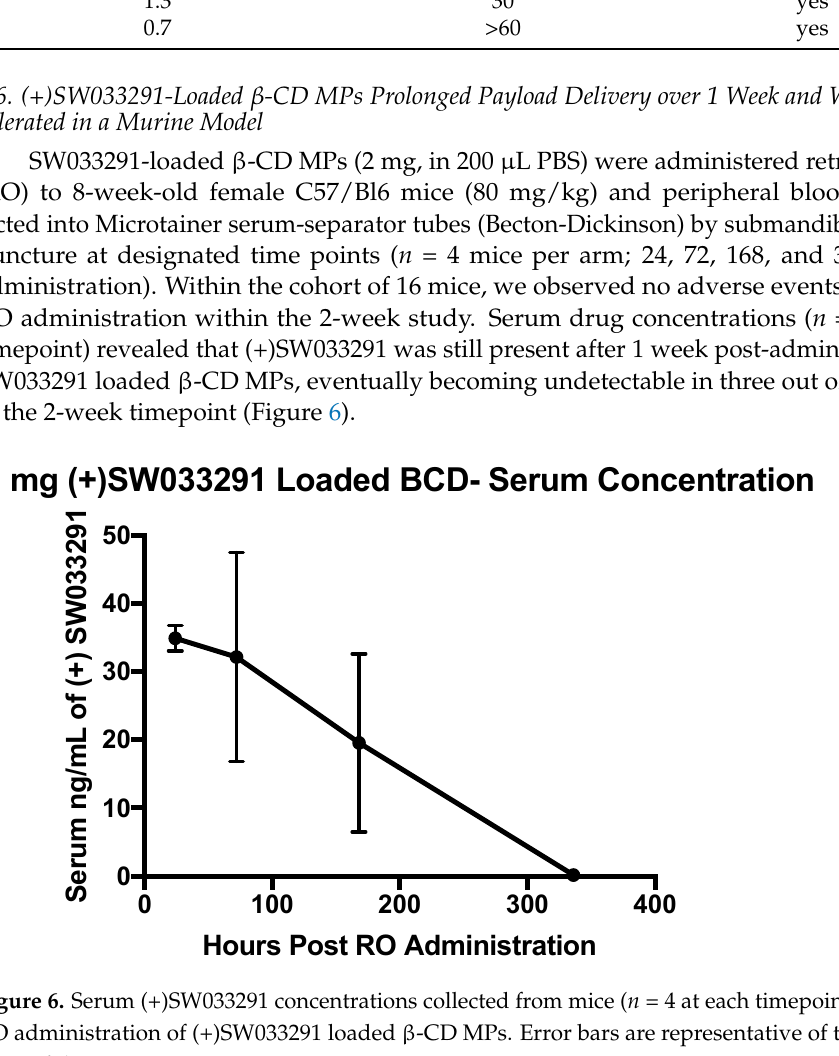
Table 3. Serial dilution of β -CD MPs in 1x PBS. Approximate settling times were measured subjec- tively when depositions of microparticles were first observed to crash out from solution. ‘Injectability’ was rated as a binary ‘yes’ or ‘no’ qualitative observation.